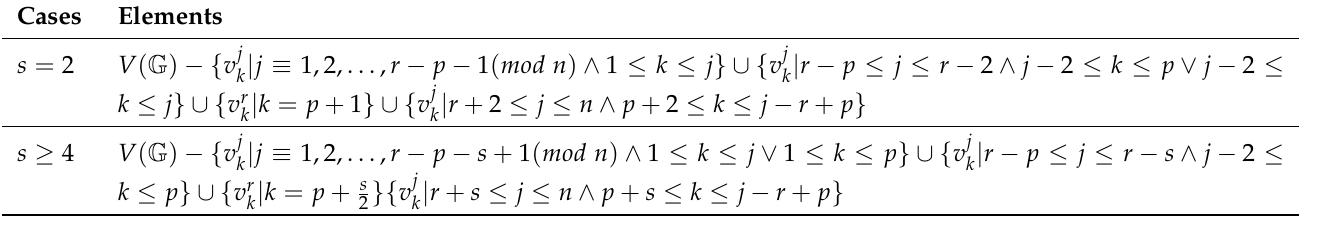
Table 2. ´ R 2 = R { v r p , v r p + s } .